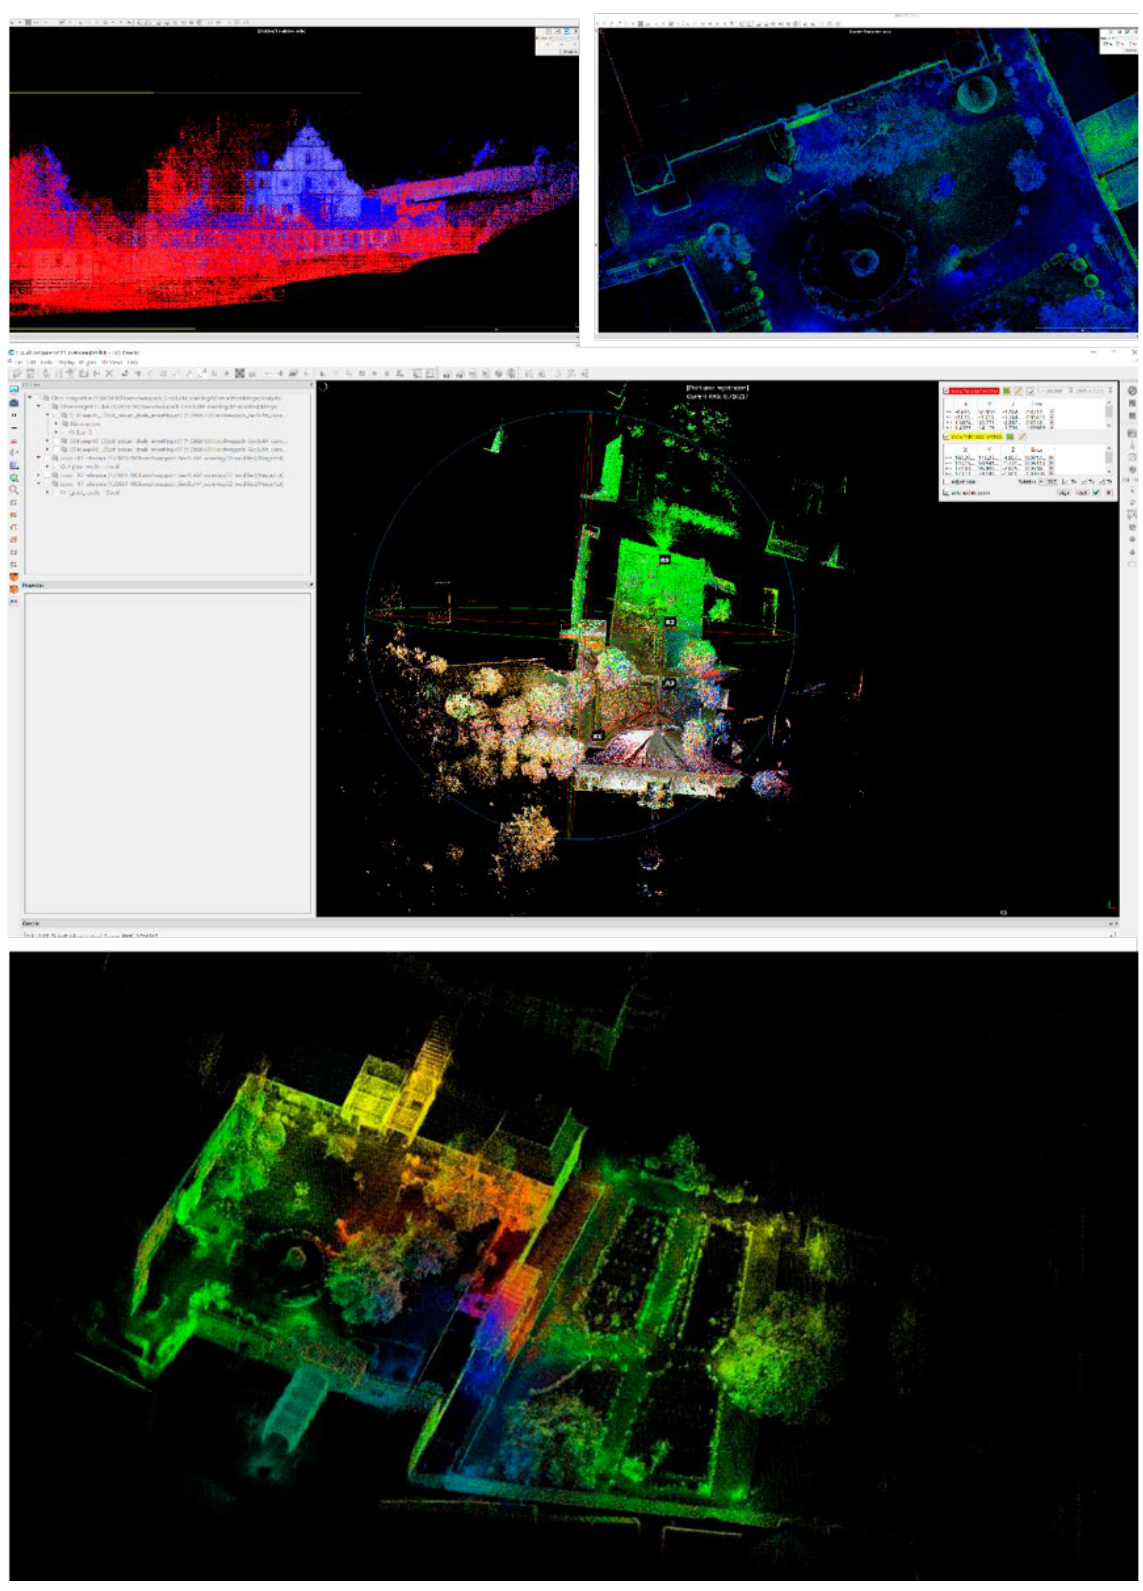
Figure 3: This overview shows steps in the processing workflow in Cloudcompare on the example of Mainstockheim. Top: point cloud to point cloud registration in section and plan, Middle: 3 or more -point-alignment, Bottom: alignment result of